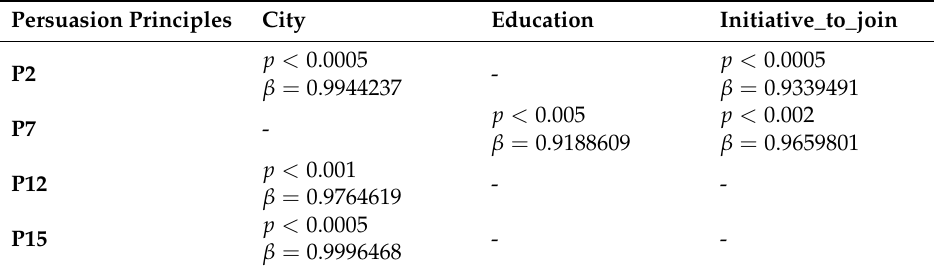
Table 6. Significant p -values (and the associated power) that ascertain the dependencies between factors and persuasive principles for the PRE survey.